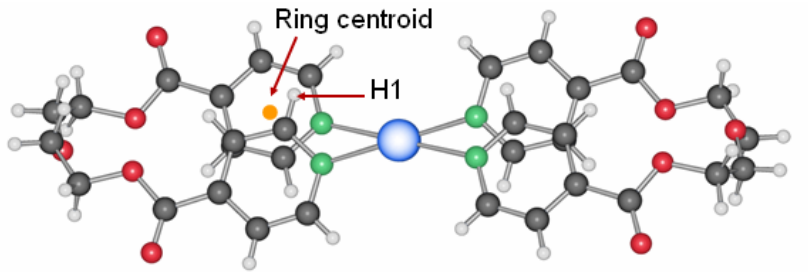
Figure 11. Aromatic interactions in the metalla-cycle system of compound 12